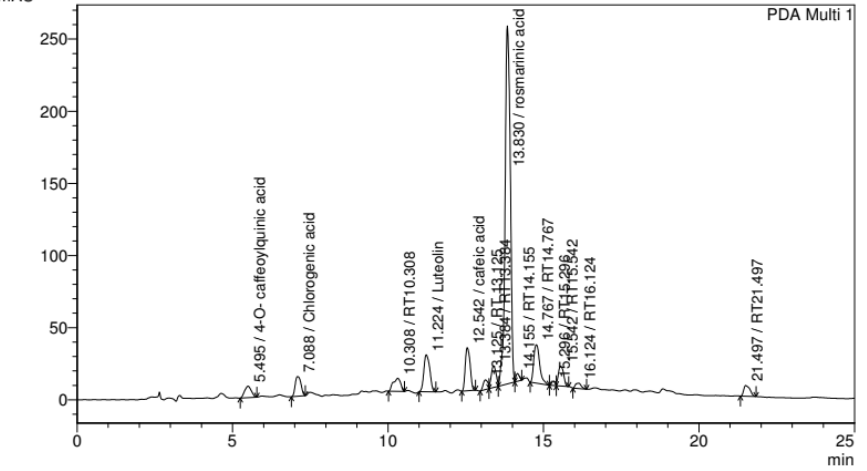
Figure 1. HPLC chromatogram from P. major extract obtained by C-18 column (250 mm × 4.6 mm × 5 µm), flow rate 1.0 mL/min, and mobile phase composed by water: acetic acid (99:1, solvent A) and methanol (solvent B) at 320 nm.